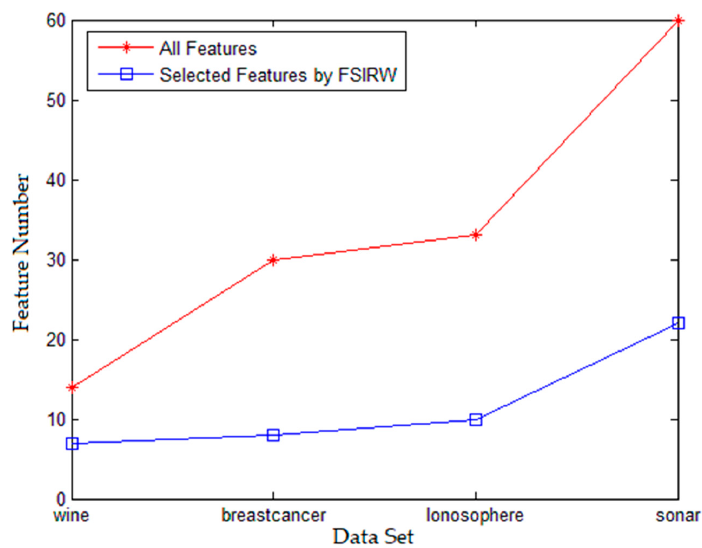
Figure 1. Feature Number Results Selected by FSIRW Algorithm.